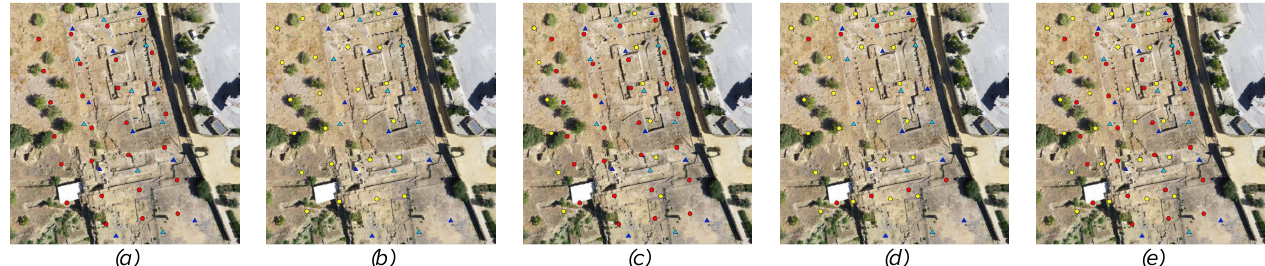
Figure 6. Different blocks configurations used for the analysis of the Temple of Isis: East-West Block (a) ; North-South Block (b) ; East- West Block including two flight strips cross block (c) ; North- South block including two flight strips cross block (d) ; Both East-West and North-South Blocks (e) ; in blue the GCPs and in cyan the CPs.